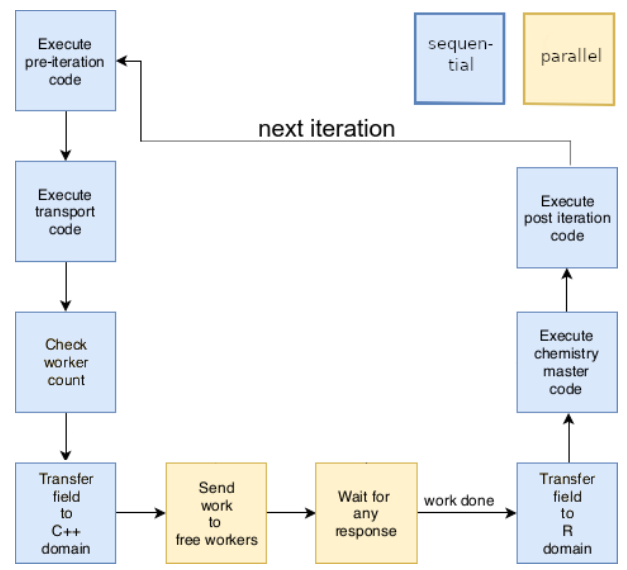
Figure 4. Overview of POET ’s master